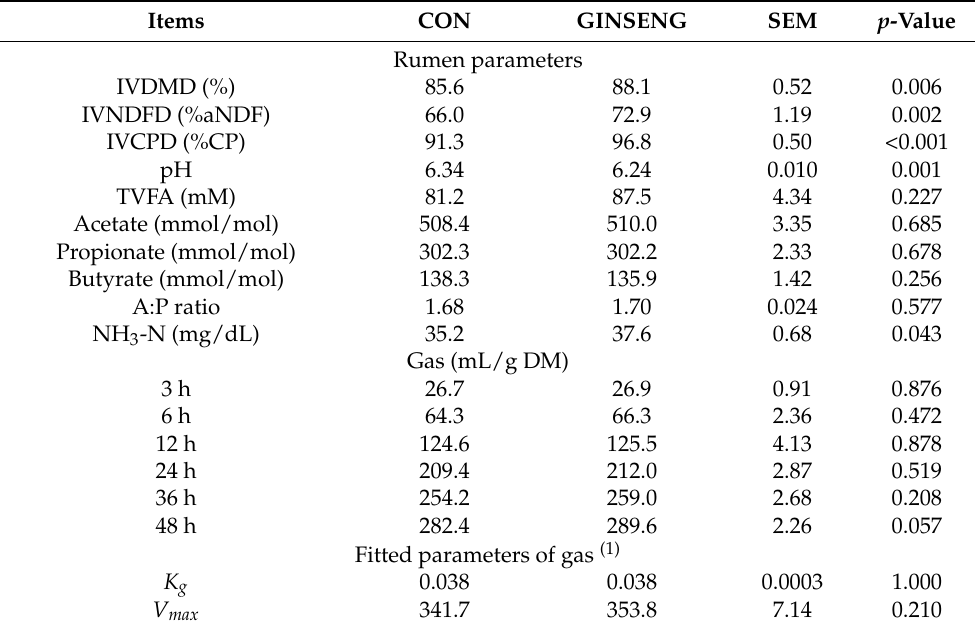
Table 4. In vitro fermentation characteristics of the experimental diets after 48 h of incubation.